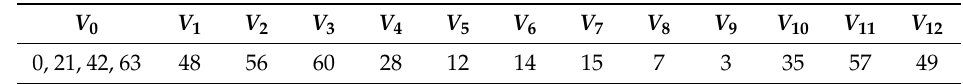
Table 2. Selected vectors in ST of conventional DTC.